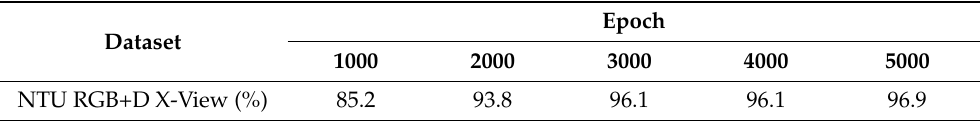
Table 7. Top 1 accuracy from various epochs.